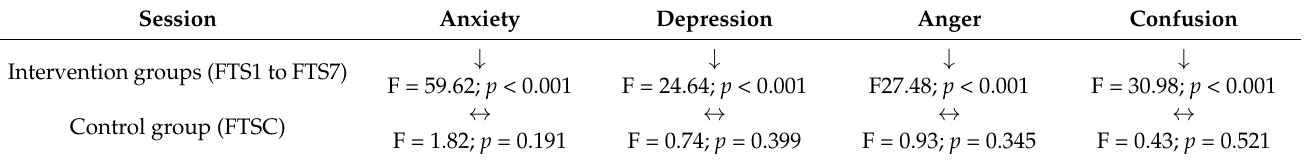
Table 4. Statistical significance of outcomes from forest therapy sessions aggregated intervention groups (FTS1 to FTS7) and control group (FTSC).